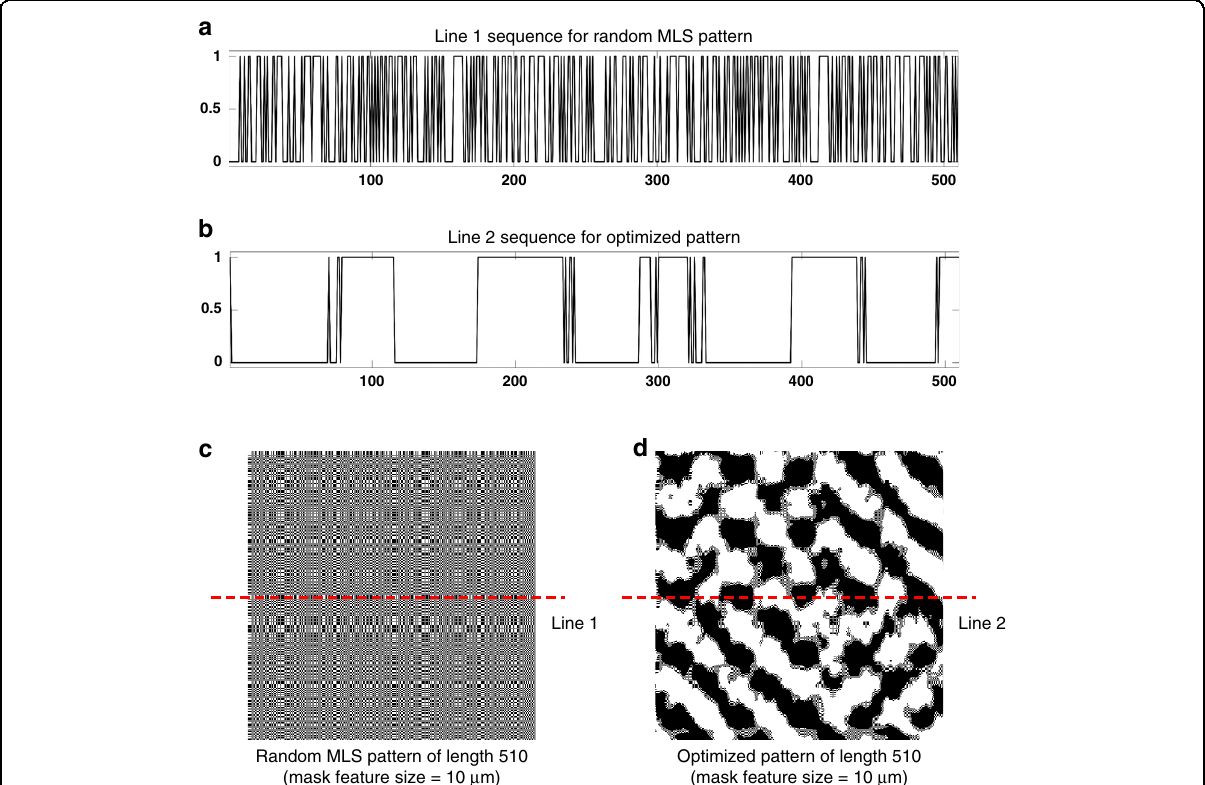
Fig. 9 Mask used in our experiment. a Line 1 (the 255 th line) sequence of random MLS pattern; b Line 2 (the 255 th line) sequence of our optimized pattern; c random MLS pattern of length 510; d our optimized pattern of length 510